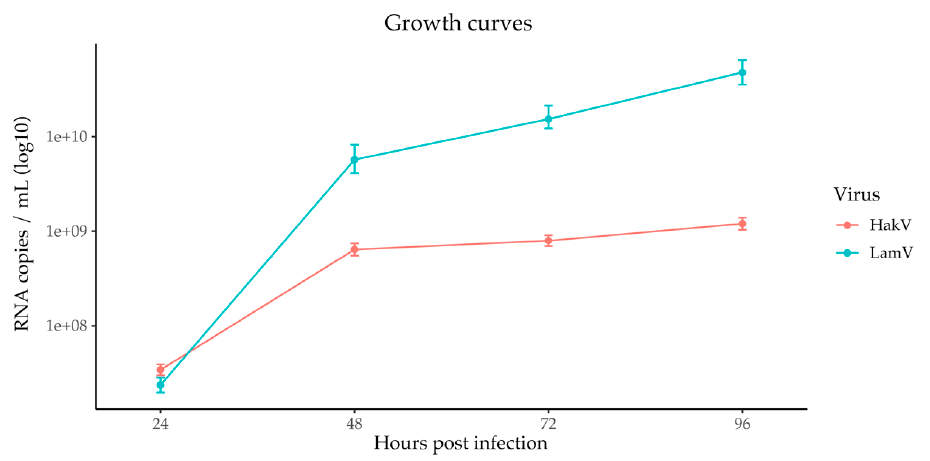
Figure 2. Growth curves of LamV and HakV in U4.4 cells, shown as RNA copies over time. Dots show the mean RNA copy numbers with a standard deviation between the biological triplicates.